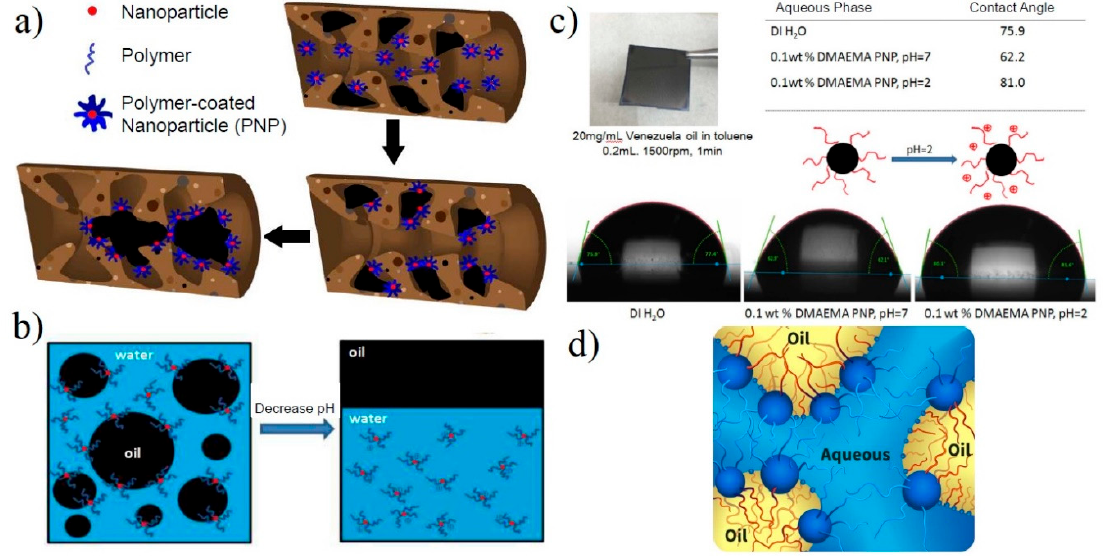
Figure 3. ( a ) Types of documents, ( b ) the number of documents per year, ( c ) the number of documents based on countries and ( d ) documents by author.